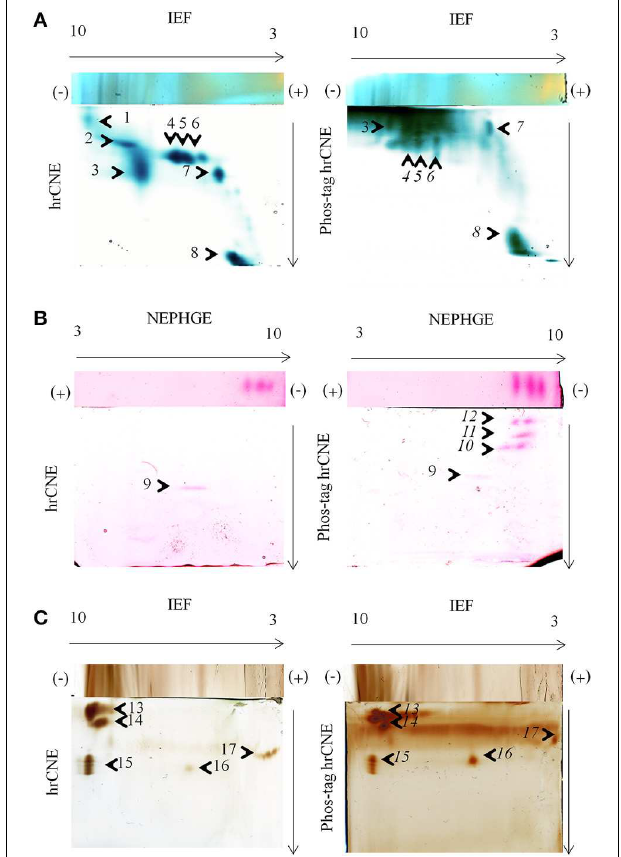
FIGURE 4 | In-gel activity in two-dimensional zymograms. Three different in-gel detections were tested for hrCNE 4–16% and phos-tag hrCNE 4–16%. (A) TMB/H 2 O 2 staining of soluble proteins (50 µ g) from maize leaves. (B) NADH-dependent Fe(III)-reductase staining with ferrozine for soluble proteins (75 µ g) of pea roots. (C) DAB/H 2 O 2 staining for total protein extracts (50 µ g) from corn roots. Separation type for the first dimension (IEF or NEPHGE) is indicated on top and second dimension on the side of the gels. The pH of the IEF (3–10) is indicated on the top of the first dimension. Arrows show the direction of protein separation. Cathode and anode are indicated as ( − ) and ( + ), respectively. Numbered spots were analyzed for the shift on phos-tag hrCNE compared to hrCNE and analyzed by LC-MS/MS, numbers of potentially phosphorylated proteins are written in italic letters.